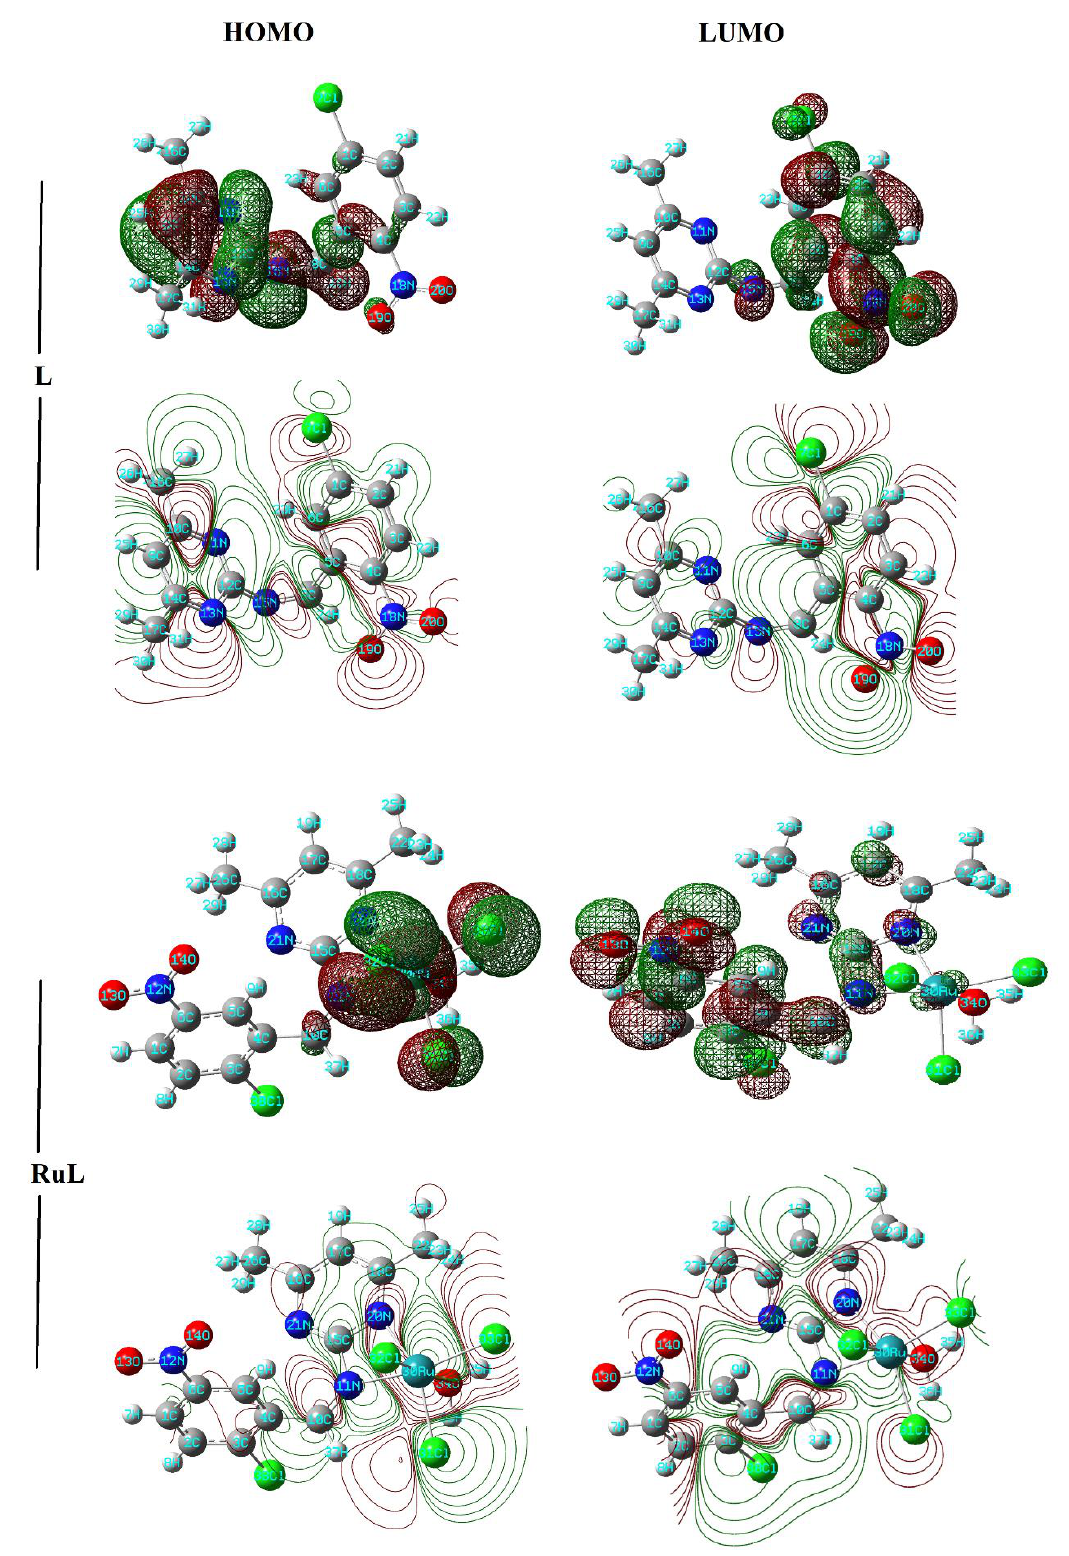
Figure 2. The HOMO and LUMO charge densities and surface contour maps of the ligand and its ruthenium complex.